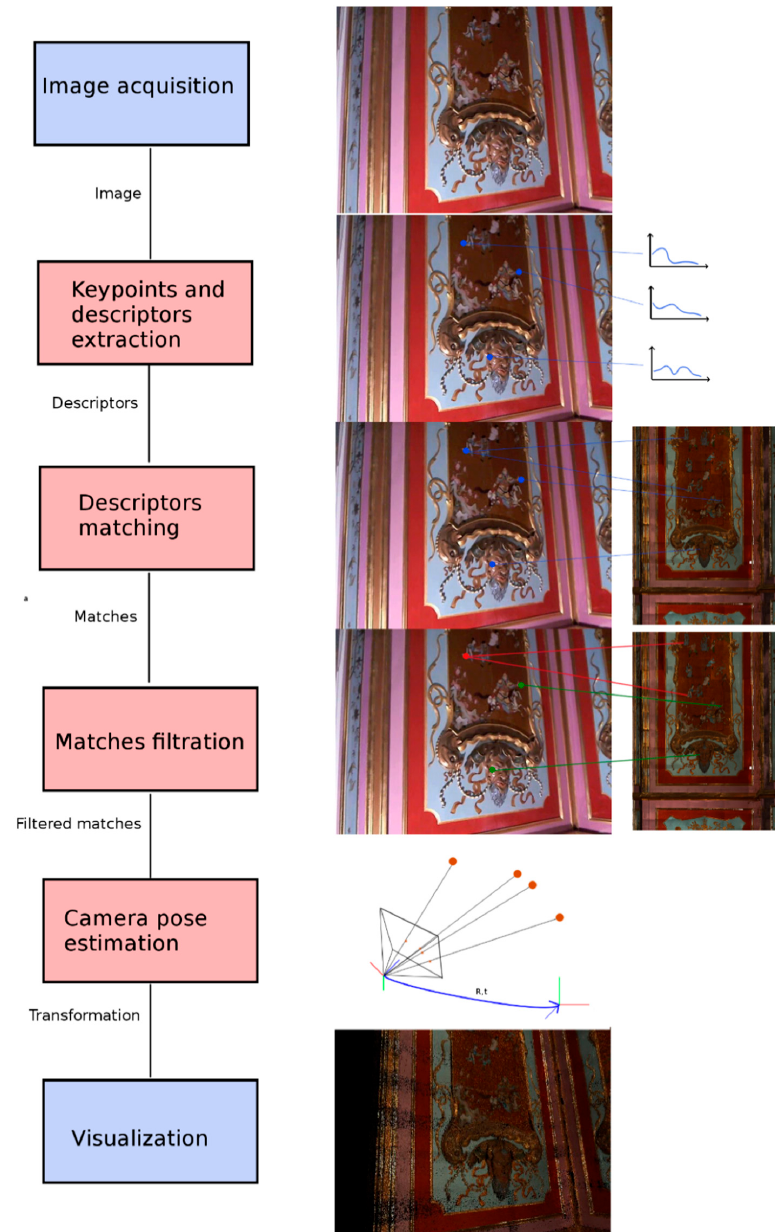
Figure 10. Runtime diagram: steps indicated with violet are performed on the mobile device; those in pink can be remotely computed.